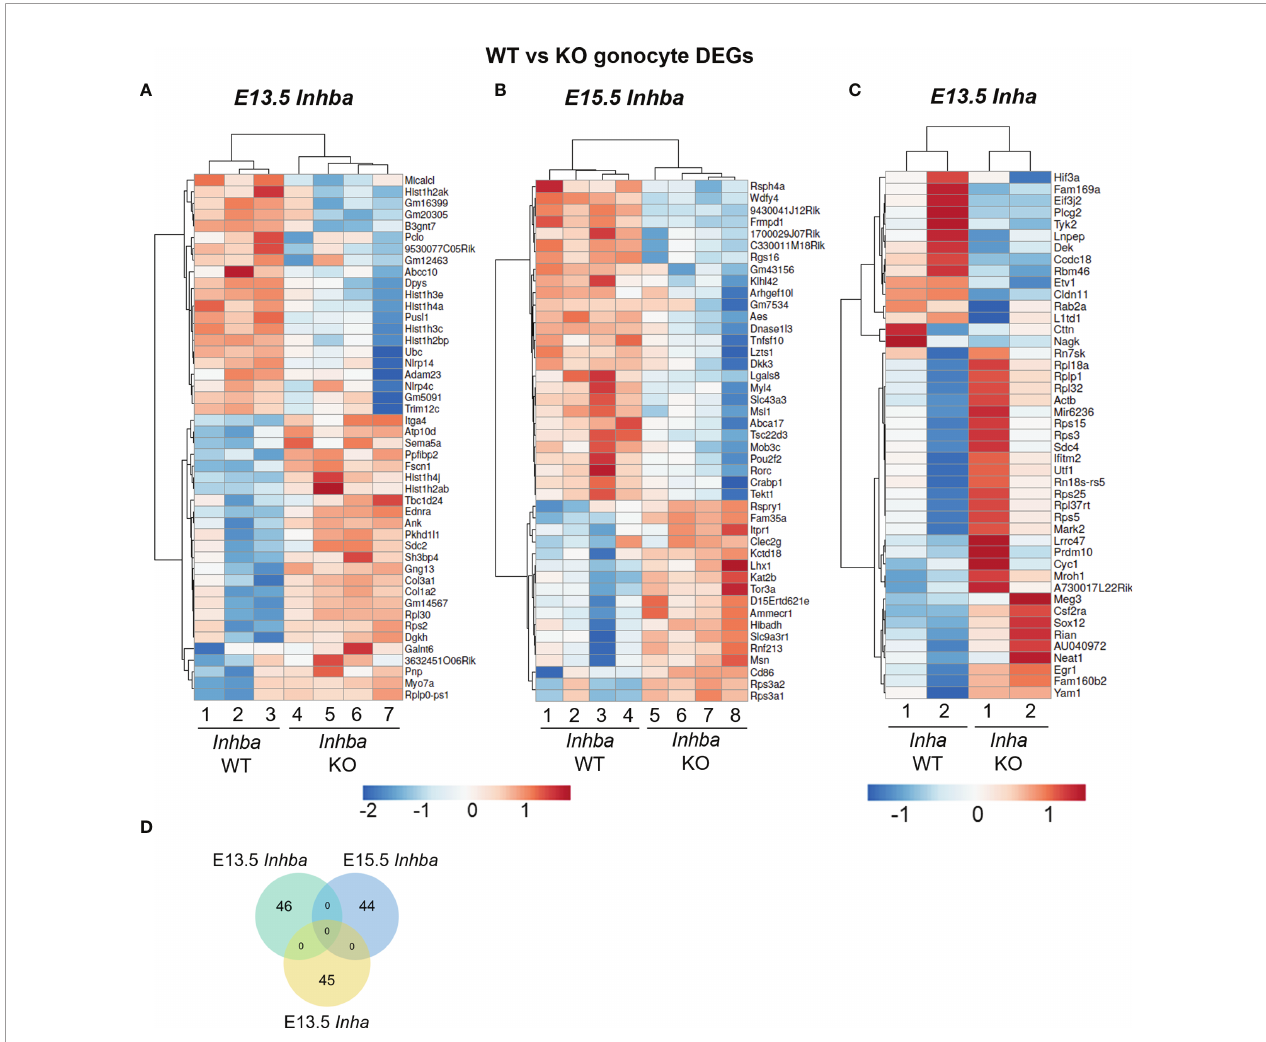
FIGURE 2 | Heatmaps generated from differentially expressed genes (DEGs) following RNA-Seq analysis. (A) 15 downregulated and 30 upregulated DEGs in E13.5 Inha knockout (KO) gonocytes compared with wildtype (WT) littermates (n=2 per genotype). DEG criteria: FDR<0.05, LogFC>0.585, <-0.585. (B) 21 downregulated and 25 upregulated DEGs in E13.5 Inhba KO (n=3) compared with WT (n=4) gonocytes. DEG criteria: LogFC>0.585, p-value<0.01. (C) 27 downregulated and 17 upregulated DEGs in E15.5 Inhba KO compared with WT gonocytes (n=4 per genotype). DEG criteria: FDR<0.05, LogFC>0.585, <-0.585. (D) Venn diagram demonstrating lack of overlap of DEGs from the E13.5 and E15.5 Inhba KO, and E13.5 Inha KO